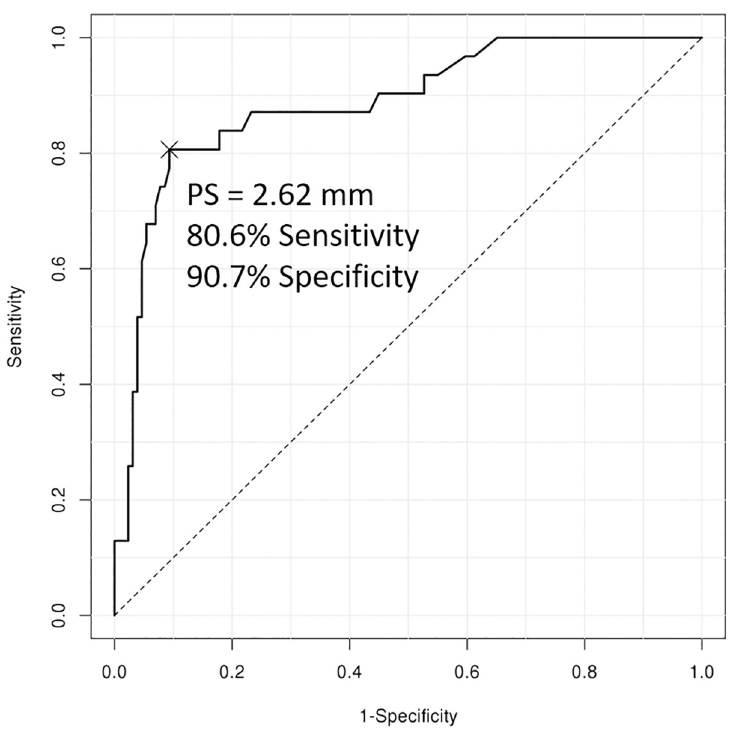
Fig 3. Receiver operating characteristic curve analysis of posterior translation of the radial head for grade 3 common extensor tendon lesion.